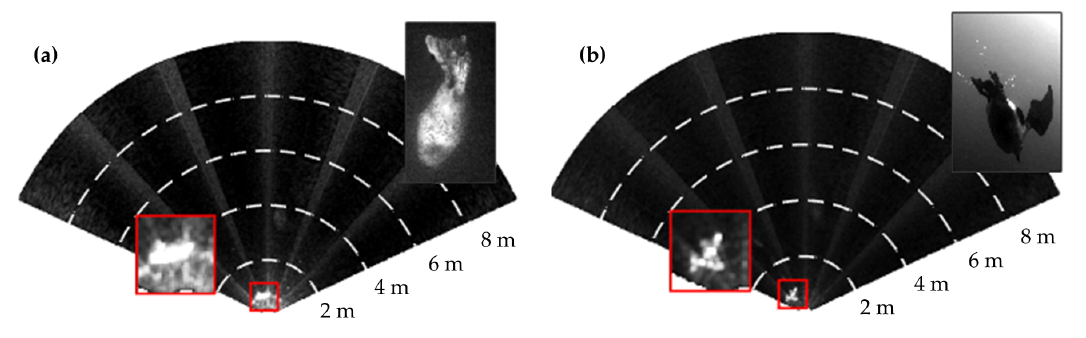
Figure 9. Comparison of optical and active acoustic (BlueView multibeam sonar, 2250 kHz) representations of a ( a ) seal and ( b ) diving bird from MSL-1. Adapted from